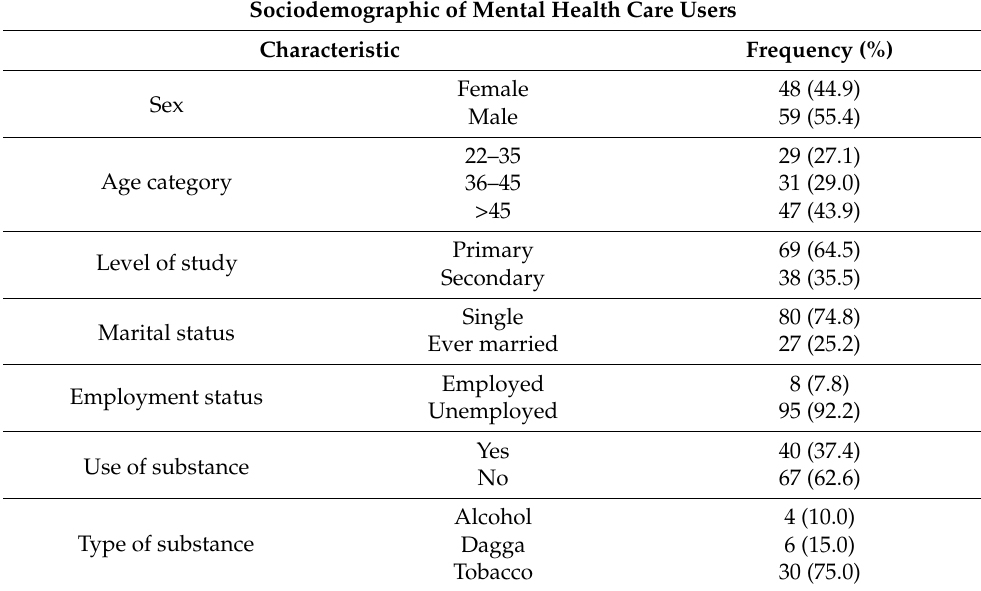
Table 1. Distribution of sociodemographic and behavioral characteristics of mental health care users ( n = 107).